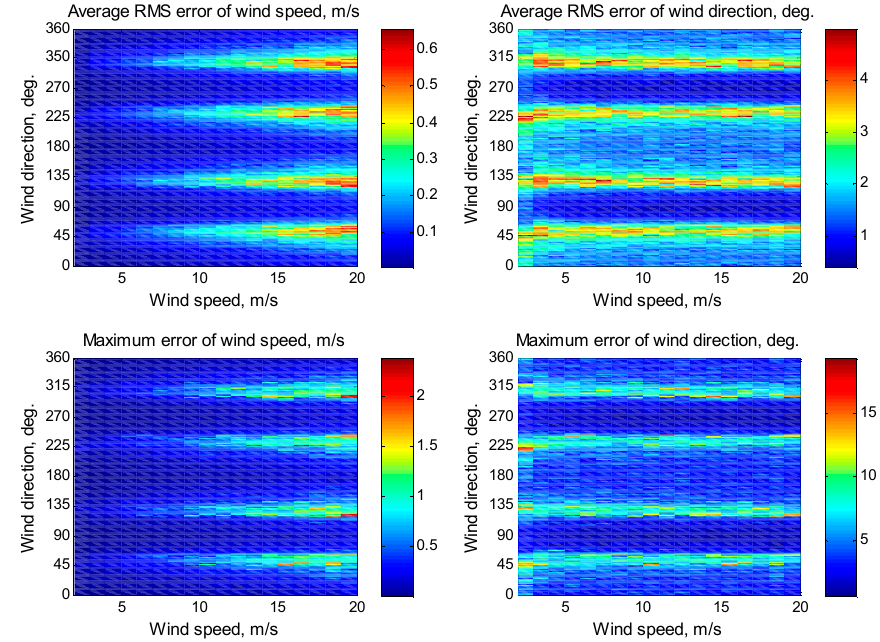
Figure 8. Simulation results for the mounting angle of a beam axis in the horizontal plane of 15° with the assumption of 0.1 dB instrumental noise at wind speeds of 2–20 m/s for the incidence angle of 30° with 5000 averaged NRCS samples for each azimuthal angle.